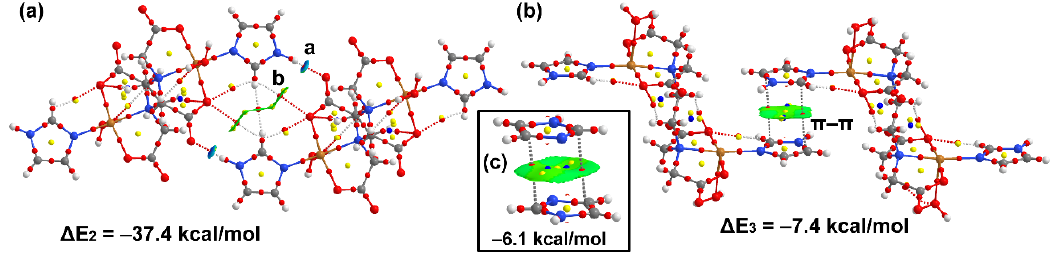
Figure 11. Combined QTAIM/NCIplot analysis of the H-bonded homodimer ( a ) and π – π homodimer ( b ) of compound 1 . ( c ) Combined QTAIM/NCIplot analysis of a π – π homodimer of two uncoordinated imidazole rings. Bond and ring critical points are represented as red and ring spheres, respectively. For the NCIplot isosurface (0.5 a.u.), the –0.04 < sign( λ 2 ) ρ < 0.04 color scale was used. Gradient cut-off = 0.04 a.u. Only the intermolecular interactions have been represented in the NCIplot index analysis.